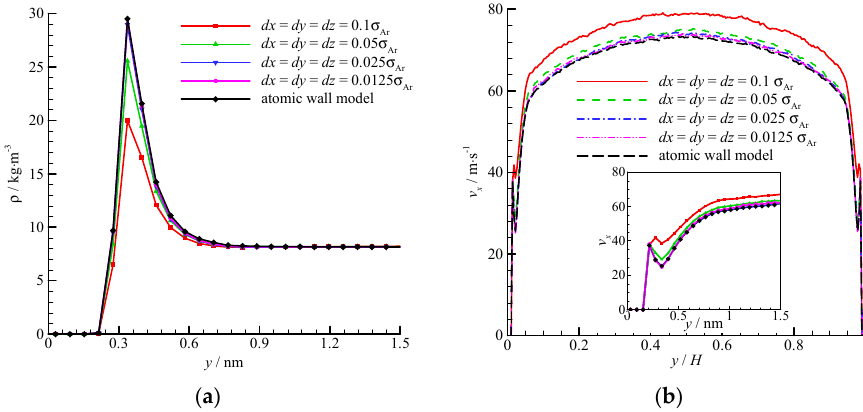
Figure 8. Comparison of the density and velocity profiles at different bin sizes, ( a ) density profile and ( b ) velocity profile. The non-dimensional wall distance (non-dimensionalized by the channel height H ) is used in large figure, and the dimensional wall distance is used in the zoomed-in figure.